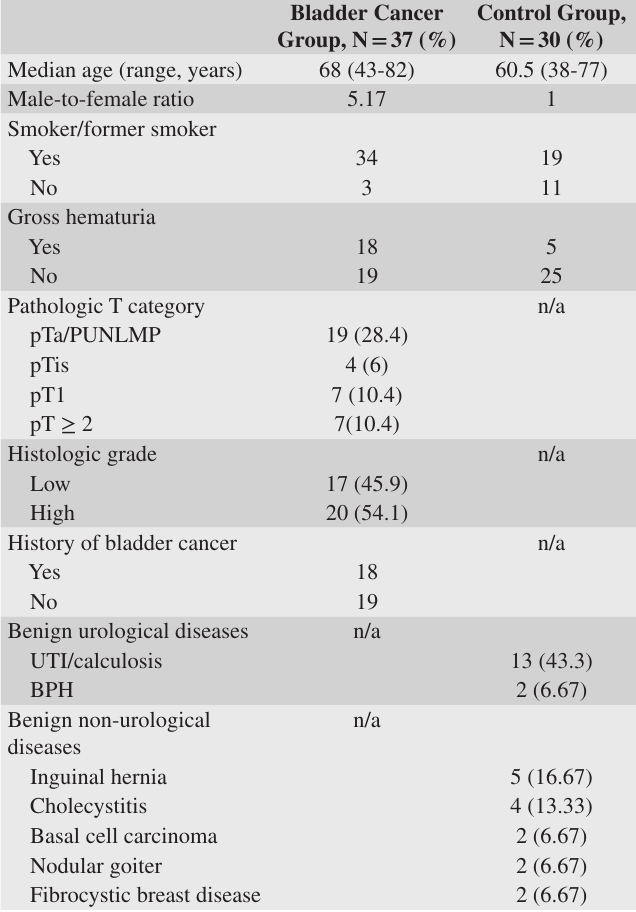
Table 1. Clinicopathologic Characteristics of the Study